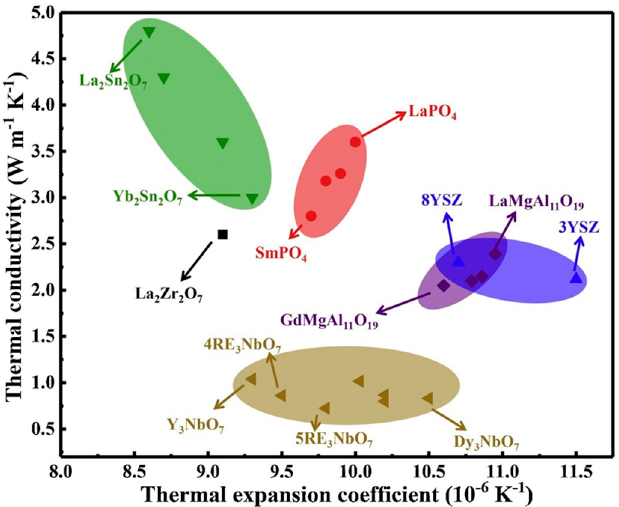
Figure 40. Thermal conductivity versus thermal expansion coefficient [216] .